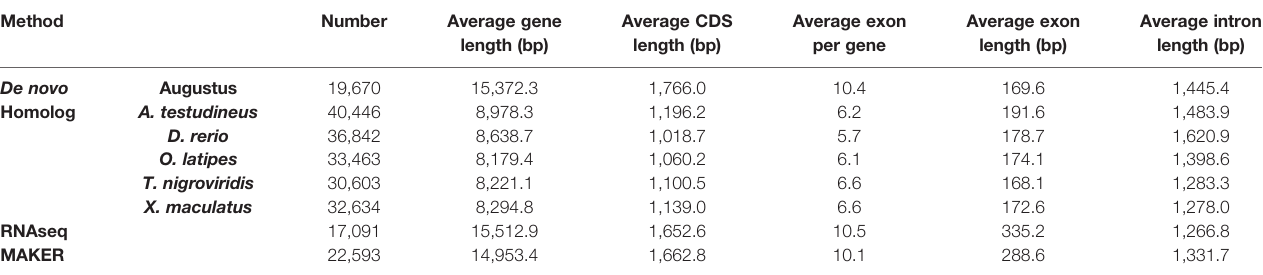
TABLE 5 | The protein-coding gene annotation in the C. argus var. genome.